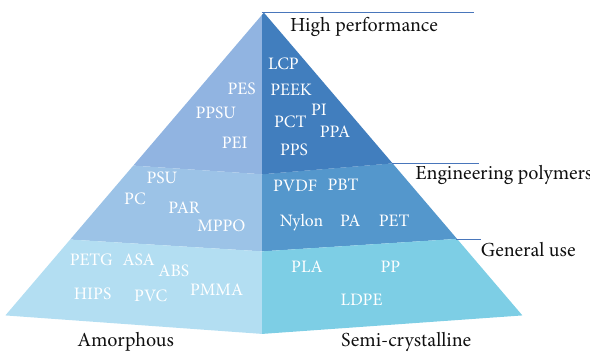
Figure 1: Various thermoplastic polymers and applications (open access article — Nader Zirak et al.